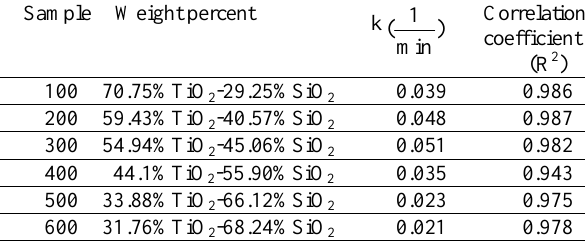
Fig. 8. Photodegradation rate of TiO -SiO 2 2 nanoparticles per SiO content in composite. 2 2 Table 5. Degradation data of TiO -SiO nanoparticles 2 2 and SiO content in 2